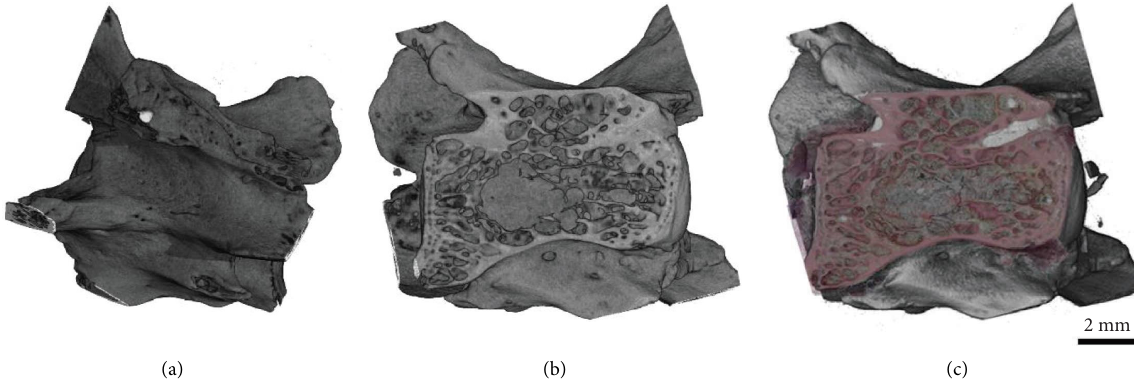
Figure 4: Exemplary fusion of a CT scan with a histological slide. Representative images of a rat vertebrae by CT. (a) Te plane of interest in the scan. (b) Te fusion of the scans allows for the combination of specifc histological features present in the stained tissue of the 2D section and (c) the global geometrical structure of the specimen found in the CT scan. Te correlation was realized by superimposing both the estimated CT-plane (b) and the corresponding histological section